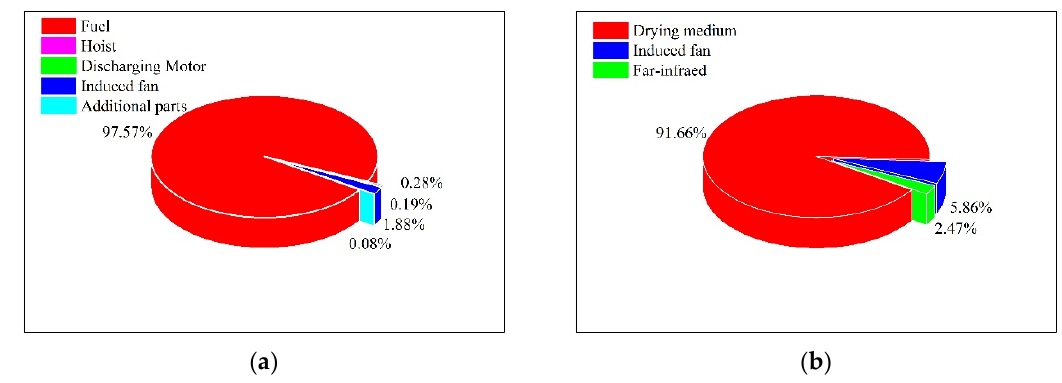
Figure 7. Assessment of overall energy consumption of ( a ) the entire drying system and ( b ) the counterflow drying chamber